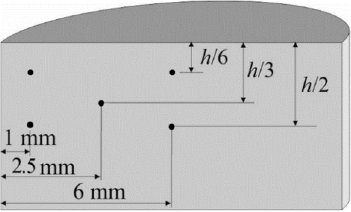
Figure 3. Microhardness indentation map on a compact diametral section. All the measured values were averaged to determine the mean microhardness.